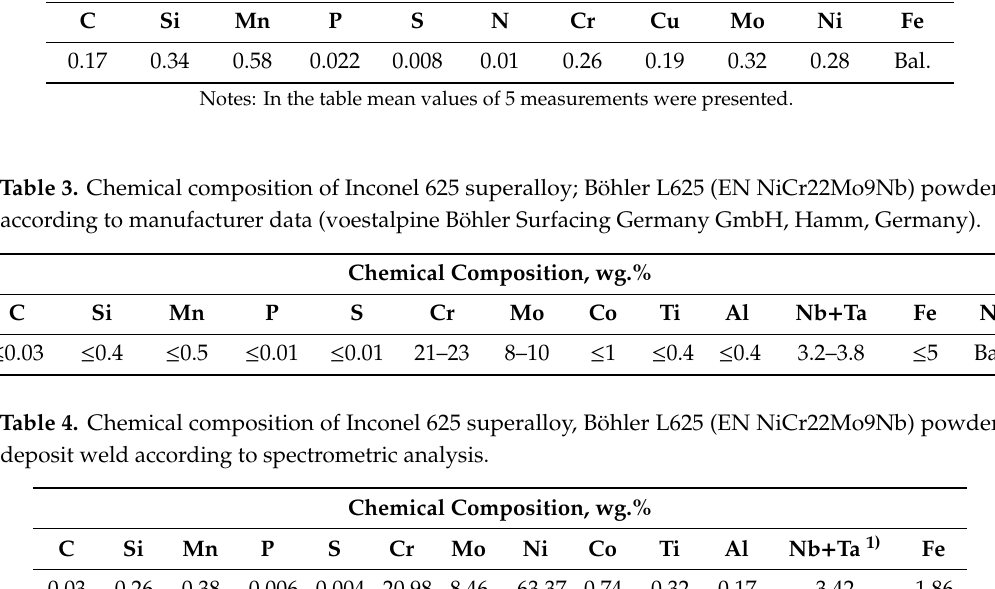
Table 2. Chemical composition of 16Mo3 steel according to spectrometric analysis. Chemical Composition, wg.%